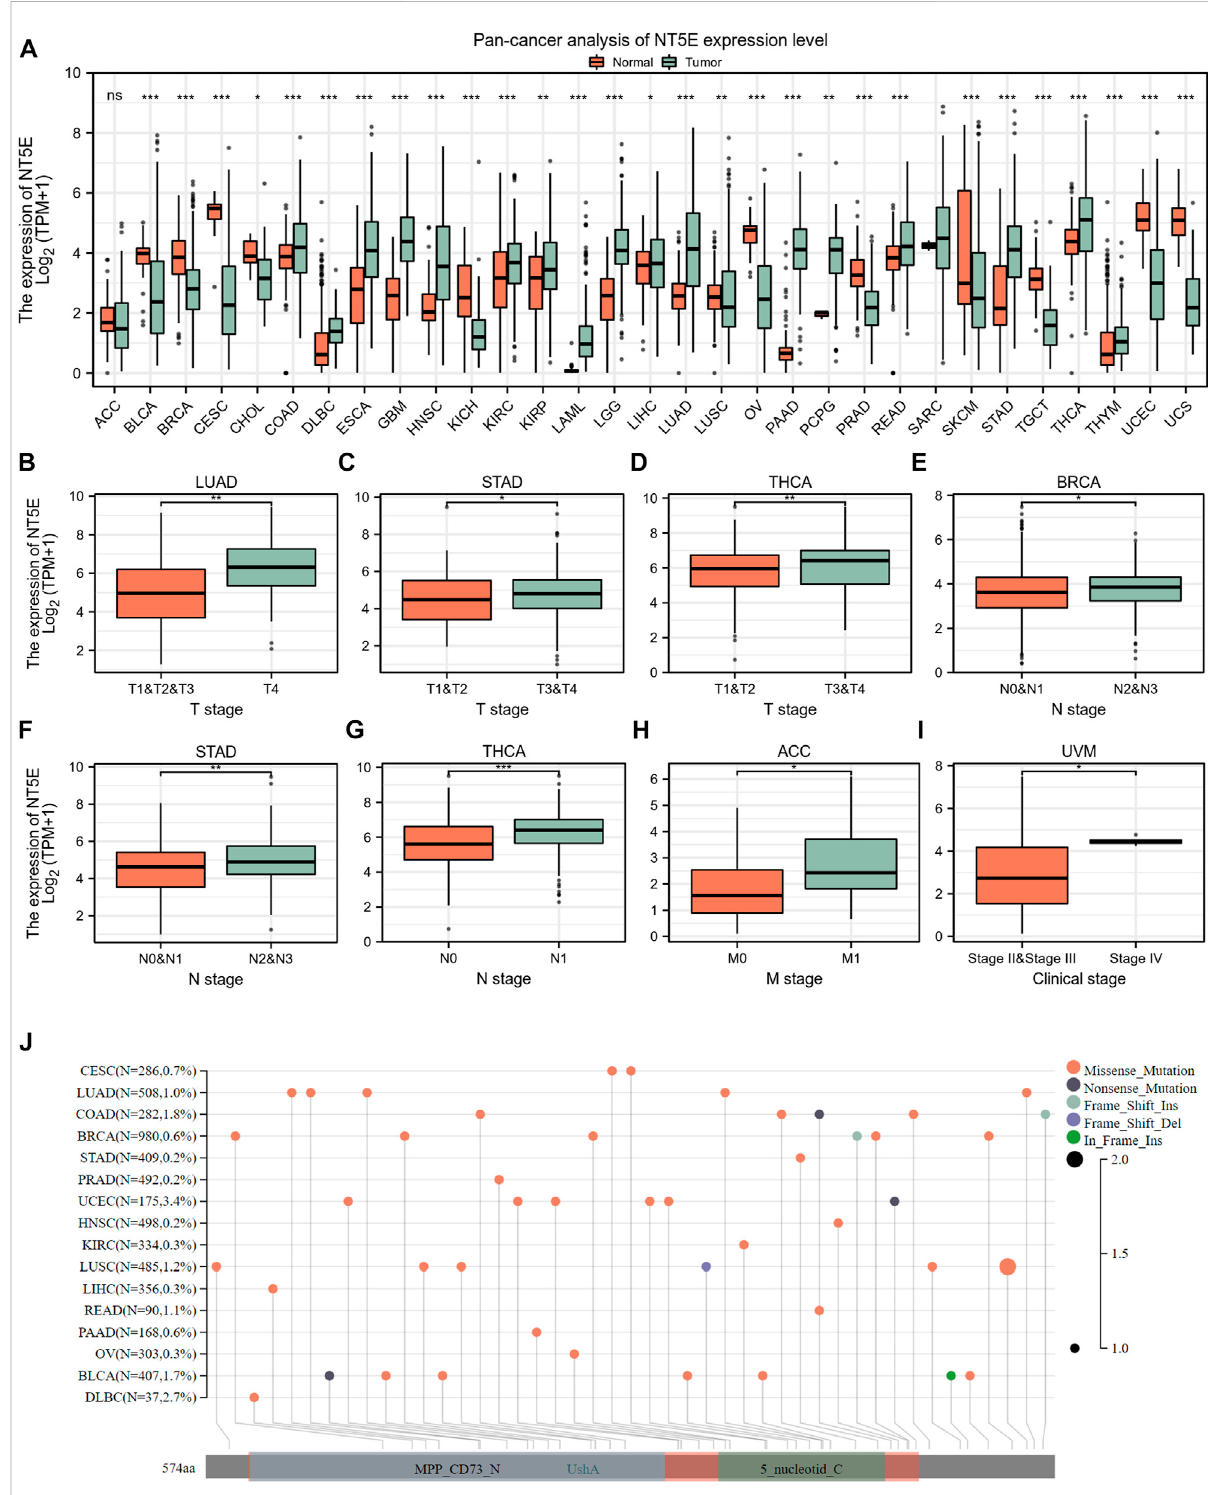
FIGURE 1 BasicinformationofNT5E. (A) TheexpressionlevelofNT5EbetweentumorandnormaltissuesineachcancerbasedontheintegrateddatafromTCGAand GTExdatabases. (B) TheexpressionlevelofNT5EbetweenT1&T2&T3andT4stageinLUAD. (C) TheexpressionlevelofNT5EbetweenT1&T2andT3&T4stage inSTAD. (D) TheexpressionlevelofNT5EbetweenT1&T2andT3&T4stageinTHCA. (E)